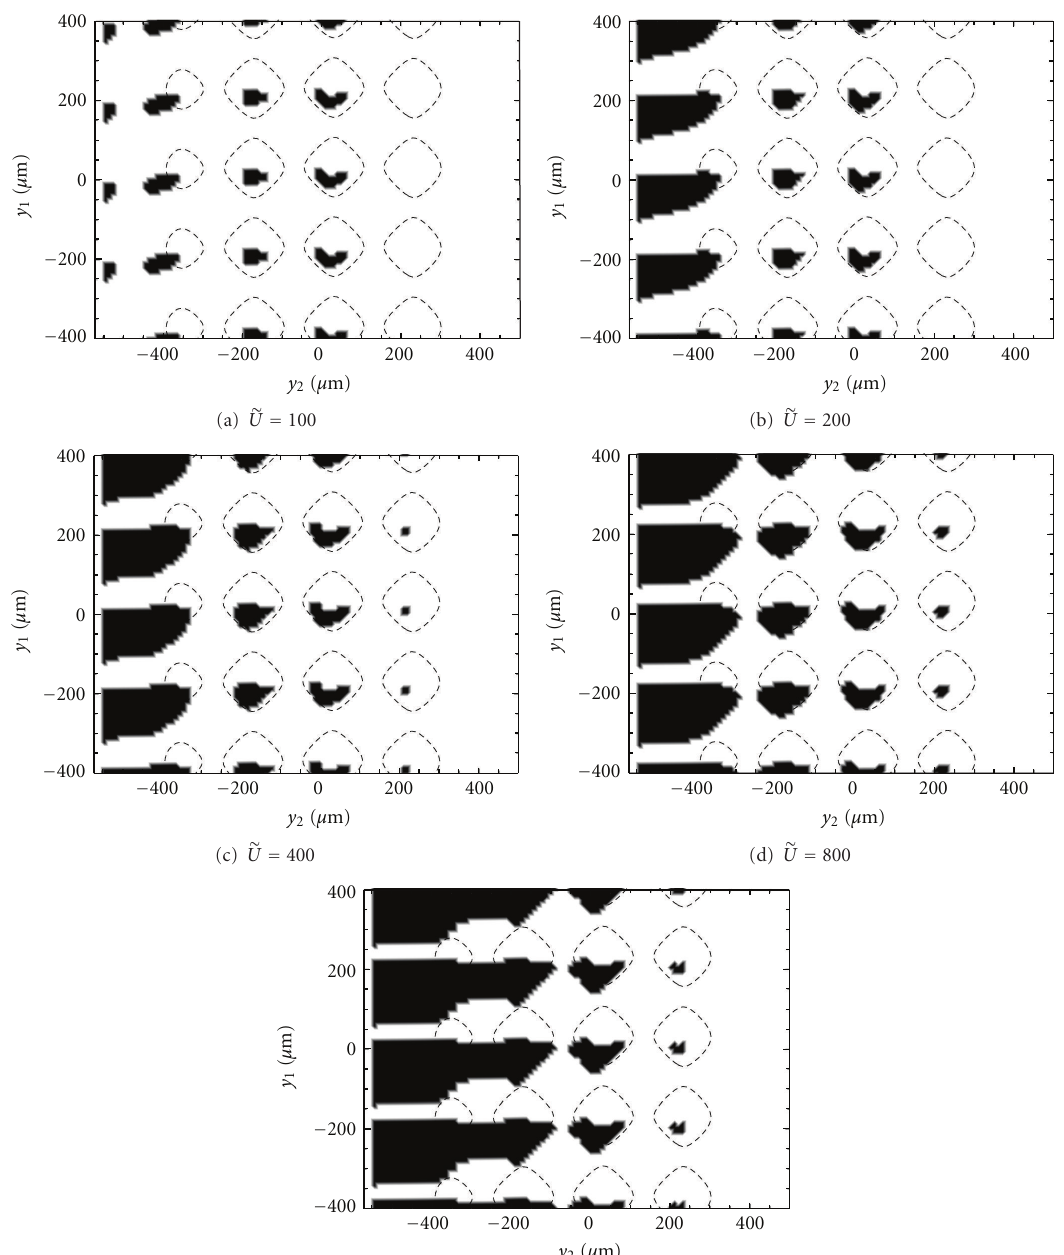
Figure 11: Cavitation domains (black areas) for di ff erent dimensionless sliding velocities.